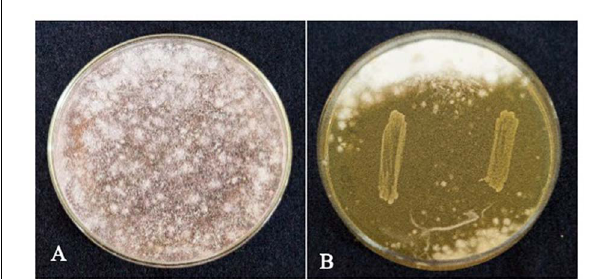
FIGURE 4 | Inhibition of F. verticillioides by L. brevis MYSN105 by agar overlay method after 4 days incubation at 26 ◦ C. (A) Control F. verticillioides .